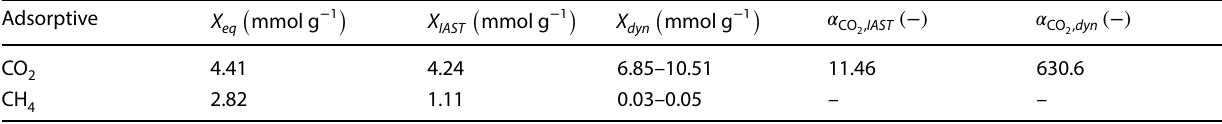
( X eq ) and for the binary mix- 2 ) to those of 2 , IAST